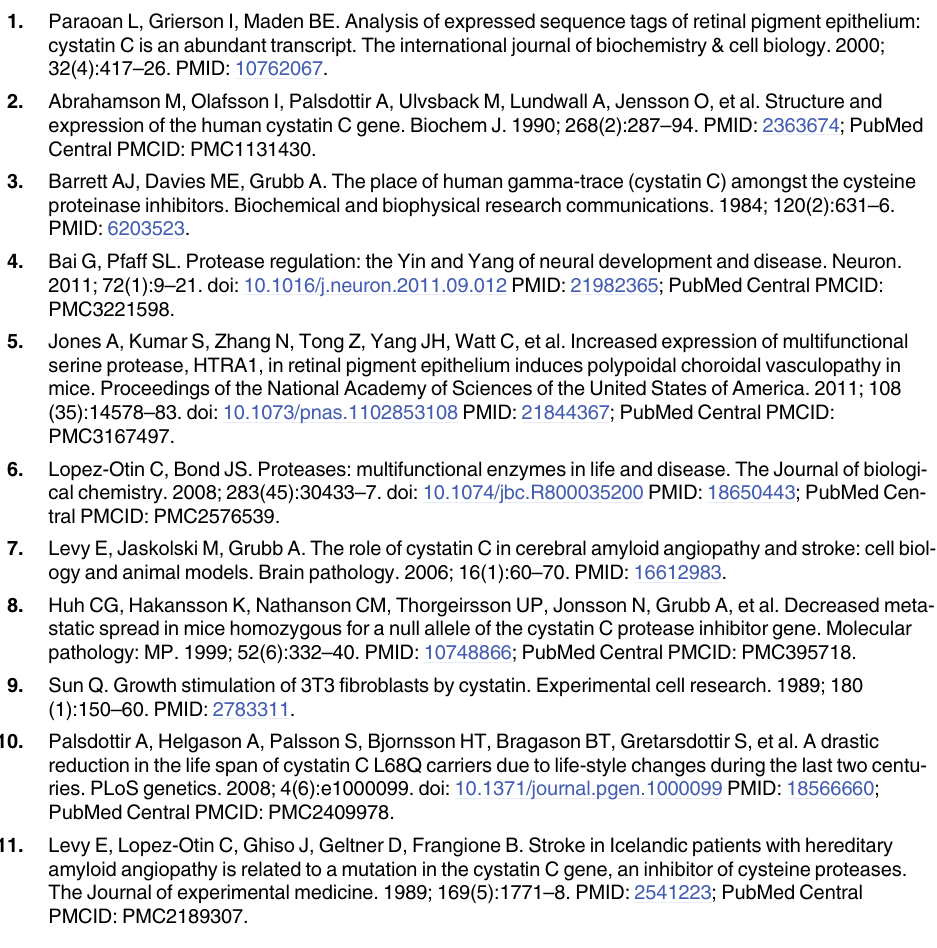
S1 Table. Predicted Cys C signal sequence cleavage sites according to different versions of SignalP